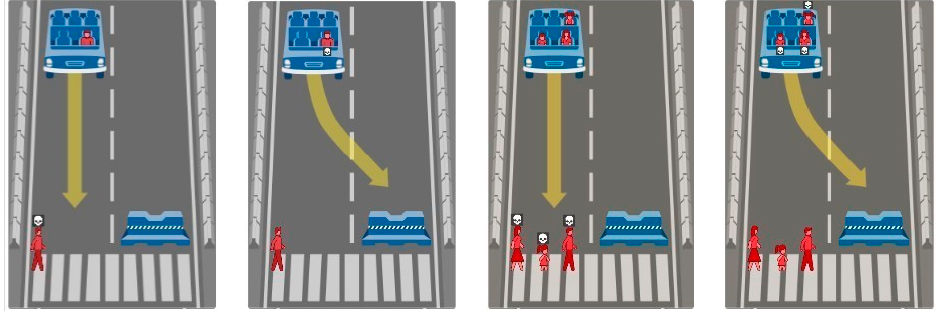
Figure 1. Sacrificing pedestrians vs. passengers (please note the skulls indicating the fatalities).